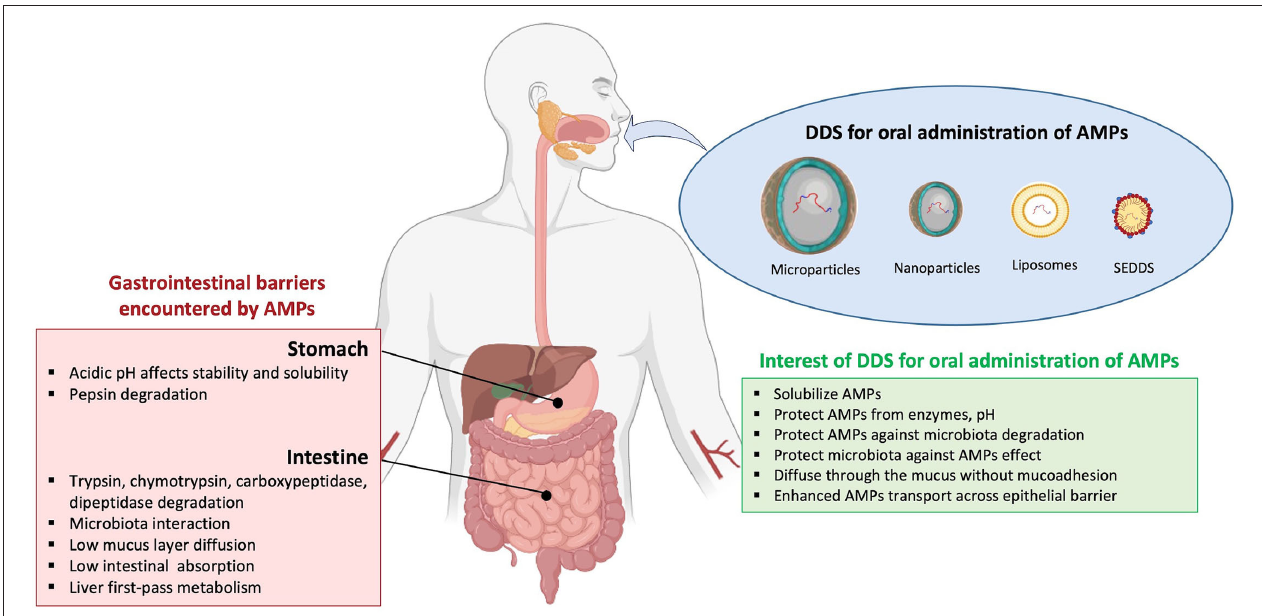
FIGURE 2 | Barriers of AMP absorption and interest of drug delivery systems by oral route. Current drug delivery systems (DDS), including microparticles, nanoparticles, liposomes, and self-emulsifying drug delivery systems (SEDDS), are assessed for oral antimicrobial peptides (AMPs) administration. The encapsulation of AMPs in DDS presents advantages to avoid gastrointestinal